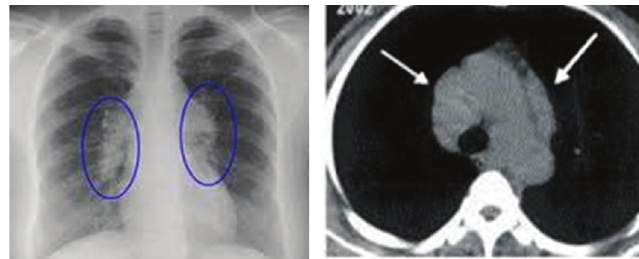
Figure 2 - Pulmonary sarcoidosis. Bilateral